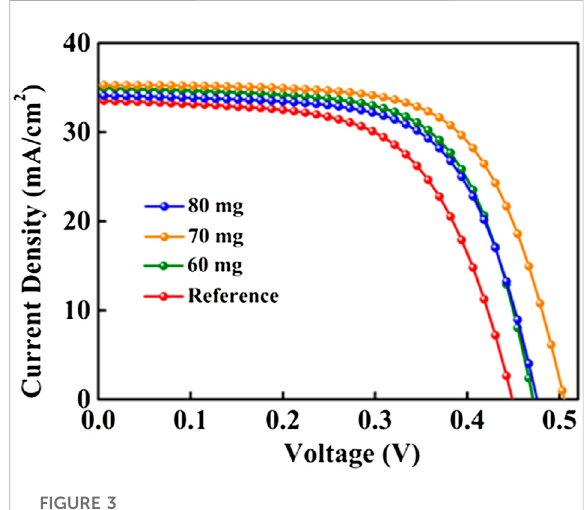
FIGURE 3 J-V curves of the best devices with CZTSSe fi lms selenized under different Sb 2 Se 3 contents.